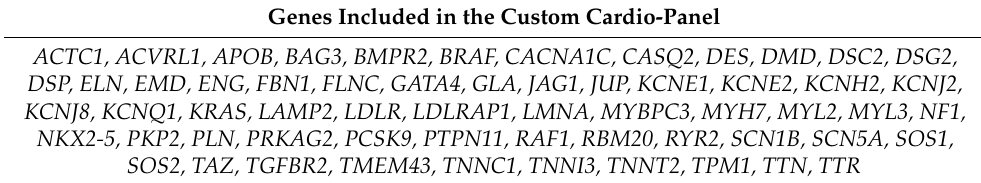
Table 1. Genes included in the custom cardio-panel covering cardiomyopathies, channelopathies, collagen and metabolic disorders.